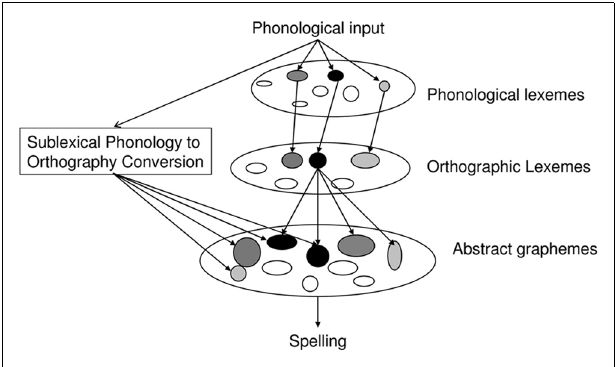
FIGURE 1 |A functional architecture of spelling to dictation. Lexical and sublexical activations are integrated at the abstract grapheme